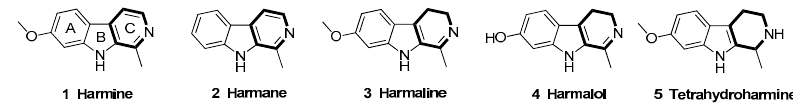
Figure 1. Representative structures of the β -carboline alkaloids.